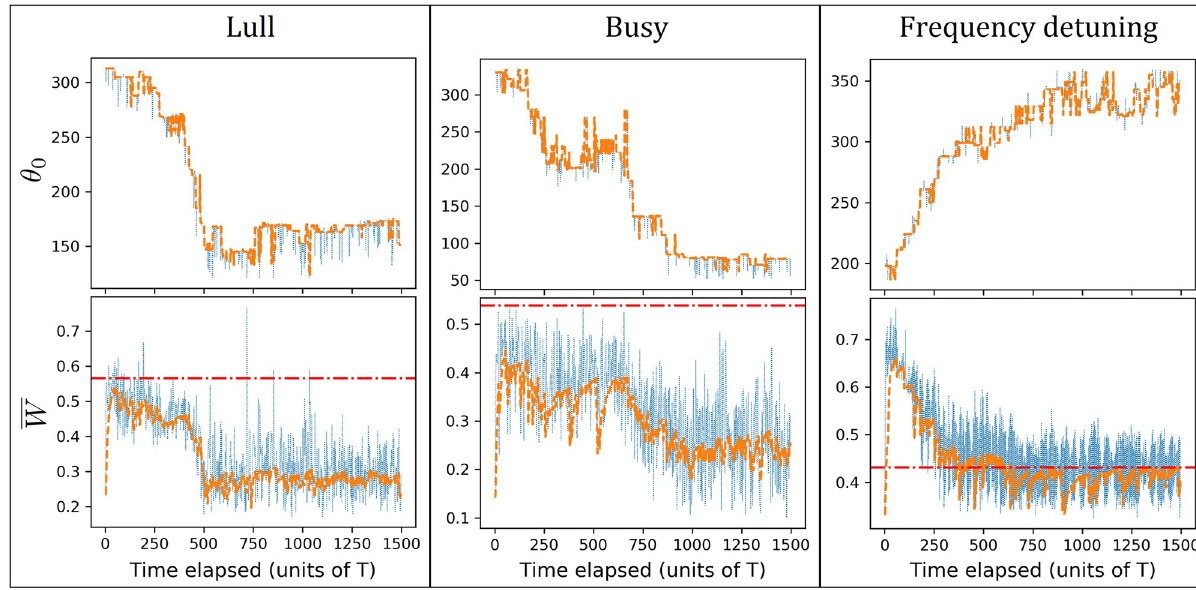
Fig 9. Top row: Graphs of best and actual expected θ 0 versus time for lull (left), busy (middle), and a lull case with frequency detuning (right). Bottom: Graphs of best and actual expected average waiting time versus time for lull (left), busy (middle), and a lull case with frequency detuning (right). In each plot, the actual curve is the thin dotted curve, whereas the best expected curve is the thick curve. The red horizontal line in the bottom graphs represents the average waiting time when the no-boarding policy is not implemented.